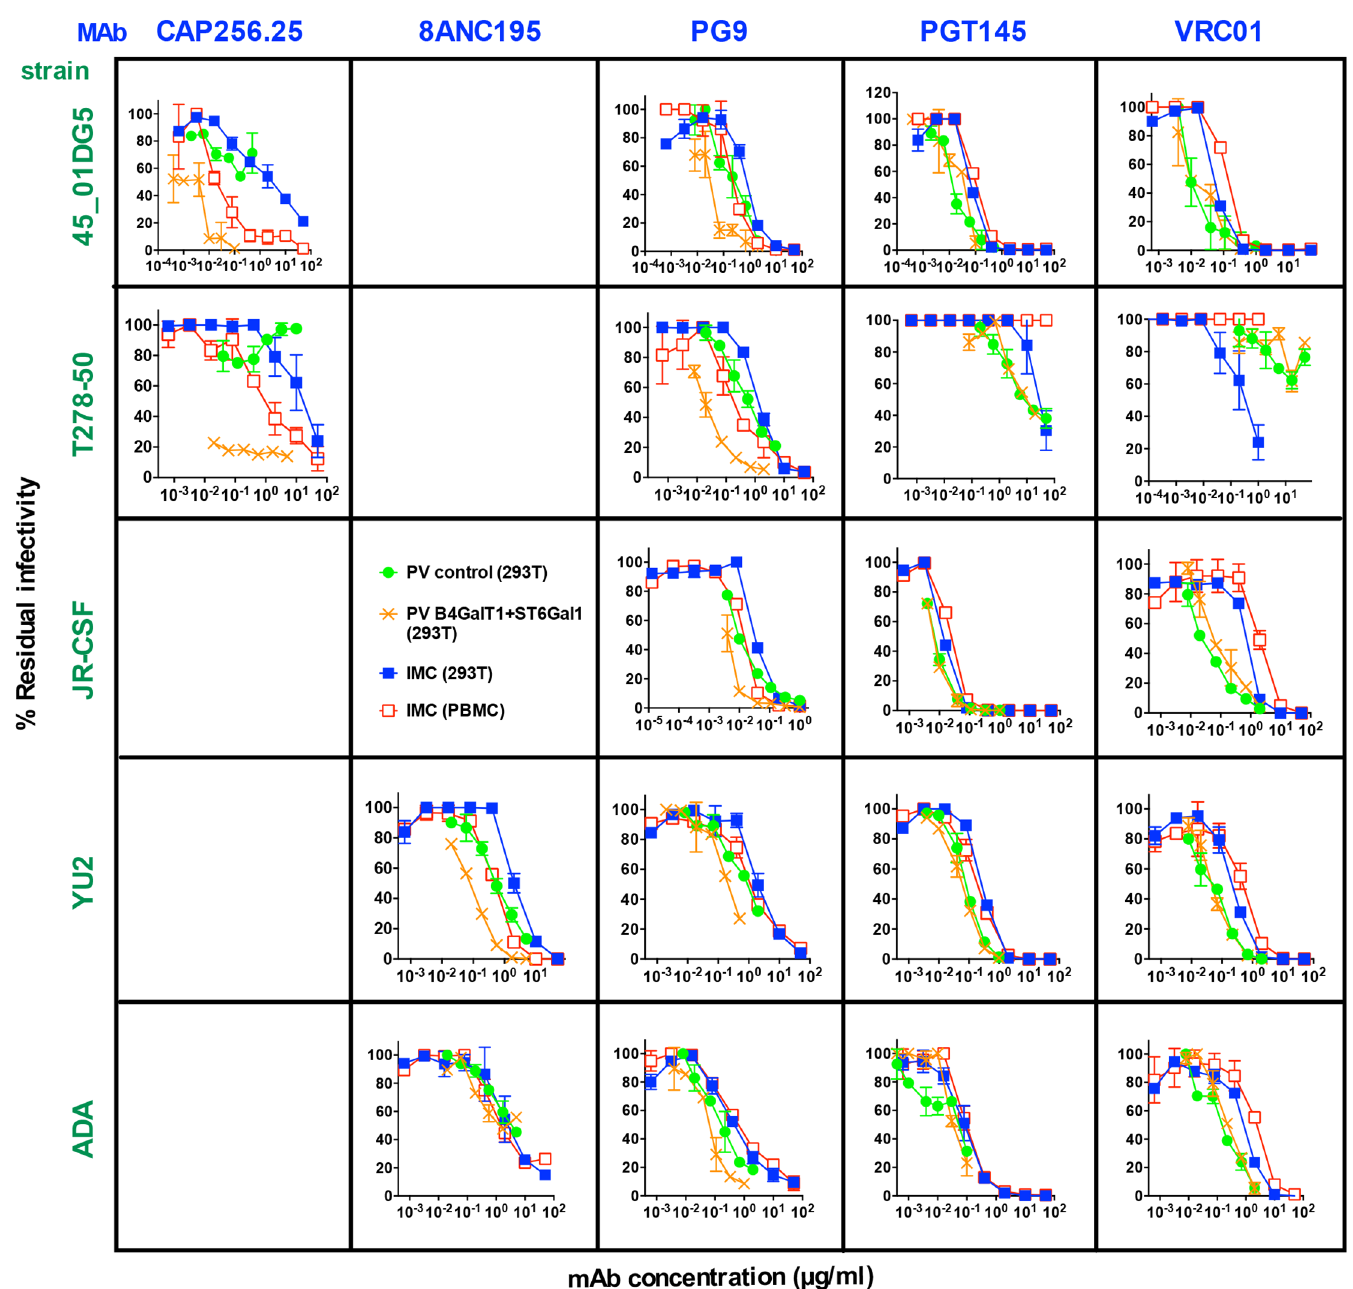
Fig 7. Comparison of the effects of B4GALT1+ST6GAL1 and PBMC passage on PV and IMC sensitivities. Viruses from 5 HIV-1 strains were produced as PVs or infectious molecular clones (IMCs). Some 293T cell-derived PVs were modified by B4GALT1+ST6GAL1, as indicated. Some IMCs were passaged through PBMCs as indicated. Neutralization assays were performed with the addition of indinavir to assays using IMCs to limit infection to a single round. Results are representative of at least two repeats performed in duplicate.